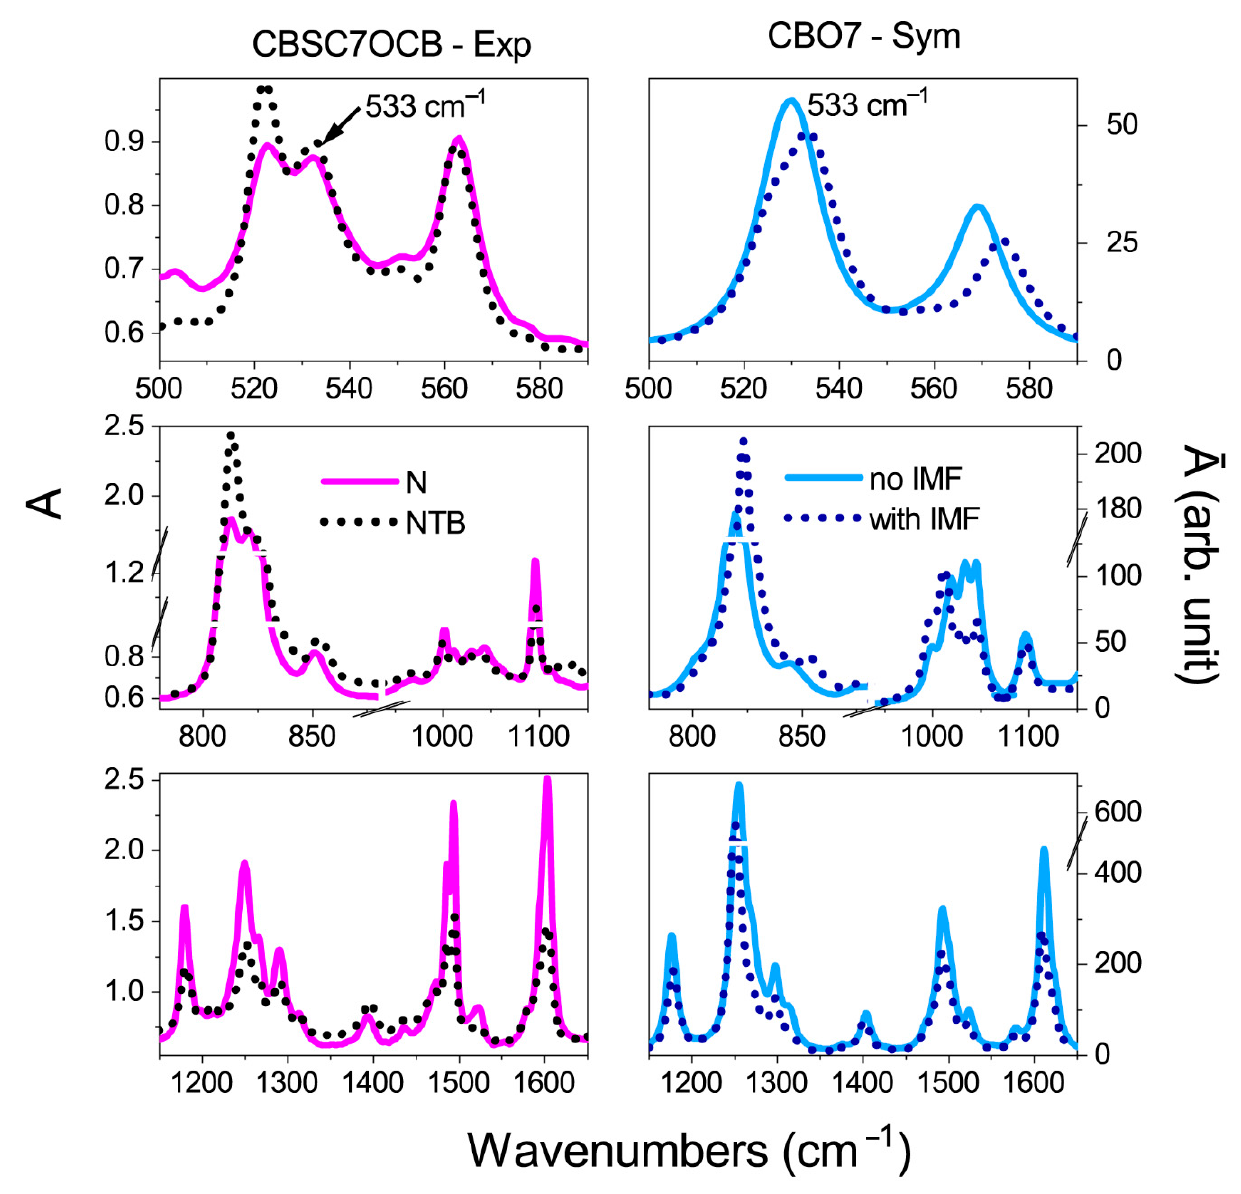
Figure 5. Comparison of the theoretical and experimental spectra for the asymmetric dimer. Left Panel: Experimental spectra of the CBS7OCB dimer, solid magenta line—the nematic phase, short black dotted line—the twist–bend nematic phase (spectrum is represented for 5 µ m cell). Right Panel: Simulations for the CBO7 monomer: solid blue line—spectra for an isolated molecule (no IMF), short navy dotted line—a system of six interacting molecules (with IMF).